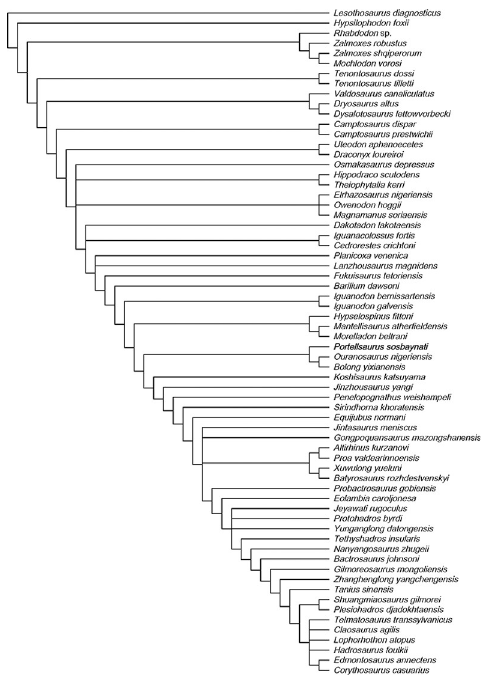
Fig 8. Phylogenetic relationships of Portellsaurus sosbaynati gen. et sp. nov. 50% majority rule consensus of 30 most parsimonious trees.